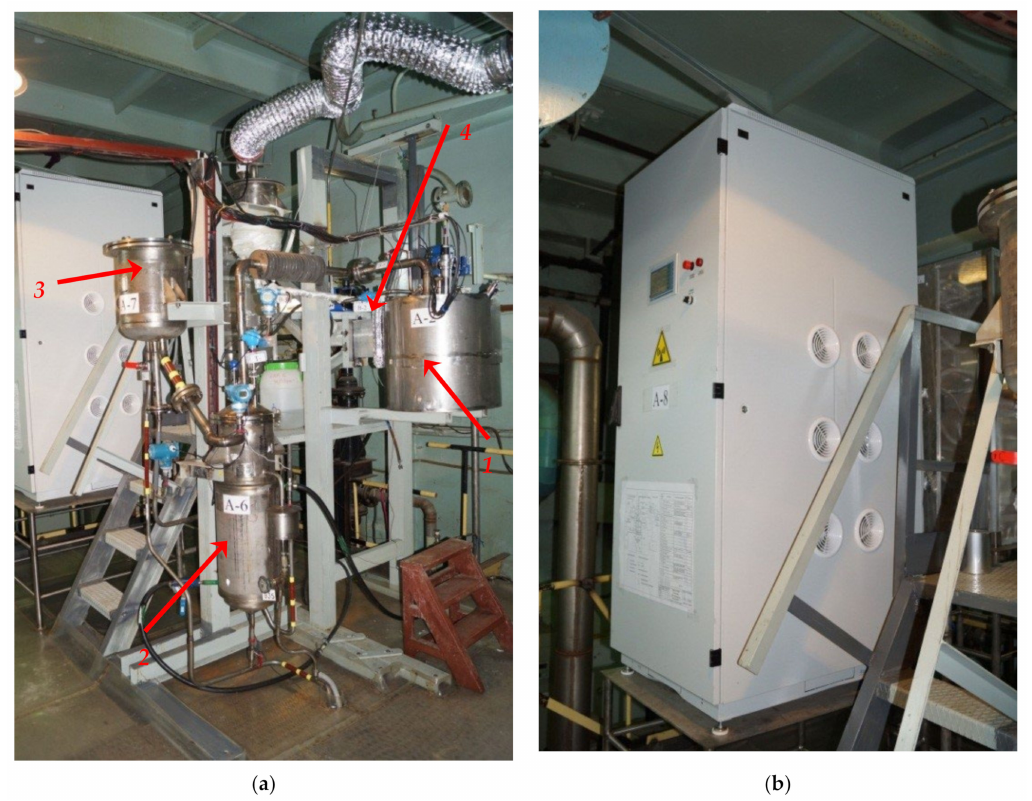
Figure 2. General view of the installation: ( a ) 1, the resonator chamber with the crucible; 2, the bubbler; 3, the dispensing vessel; 4, the waveguide) and ( b ) the magnetron control